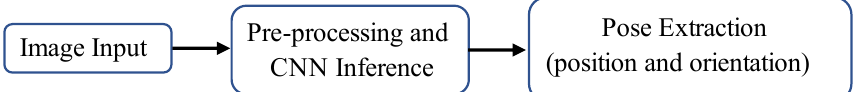
Figure 1. Typical Convolutional Neural Network (CNN)-based Pose Estimation